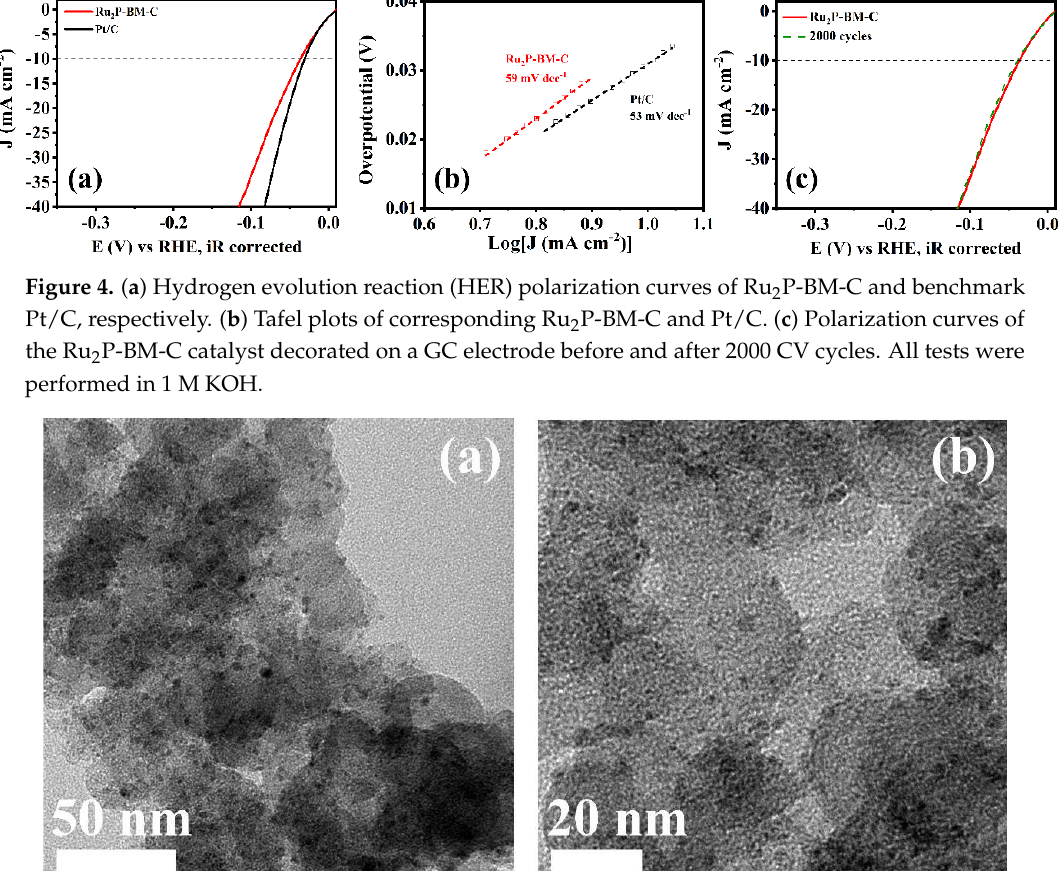
Figure 5. ( a , b ) TEM images of Ru 2 P-BM-C after 2000 CV cycles.